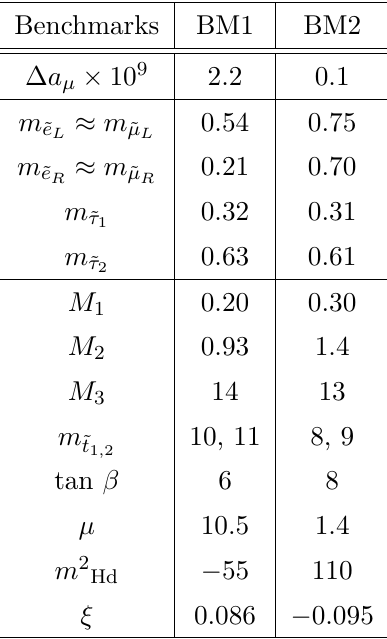
Table 1 . Benchmark model parameters for MSSM. All quantities of mass dimensions are in units of TeV (2) . The first benchmark (BM1) accounts for the current muon g − 2 anomaly, and has a metastable standard EWSB vacuum. The second benchmark (BM2) has an absolutely stable standard EWSB vacuum and shows the possibility of detectability in future DM direct detection experiments, but with much smaller BSM contribution to muon g − 2